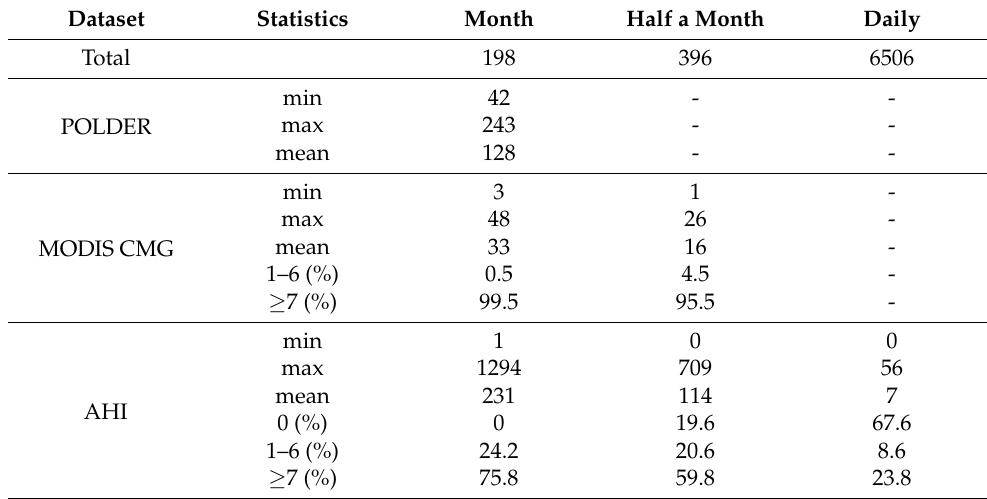
Table 6. Numbers of accumulated observations at 198 pixels over different time